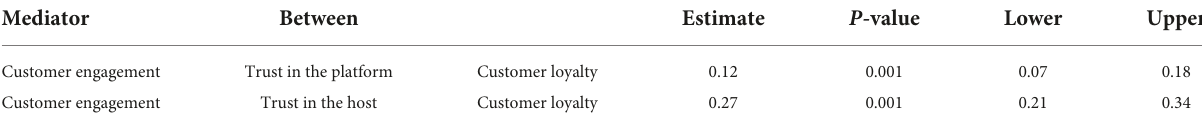
TABLE 7 Mediation test results.